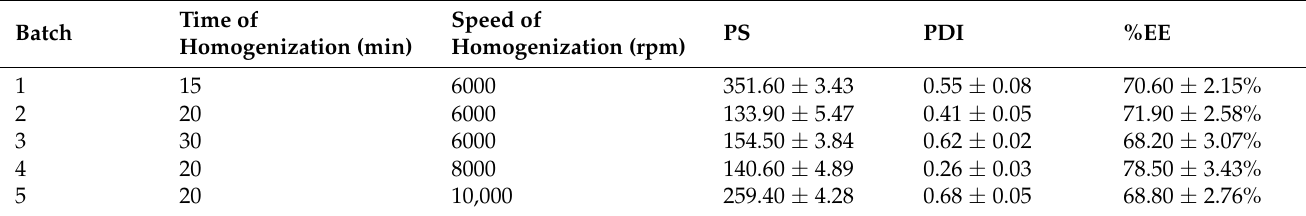
Table 4. Preliminary screening of speed and time of